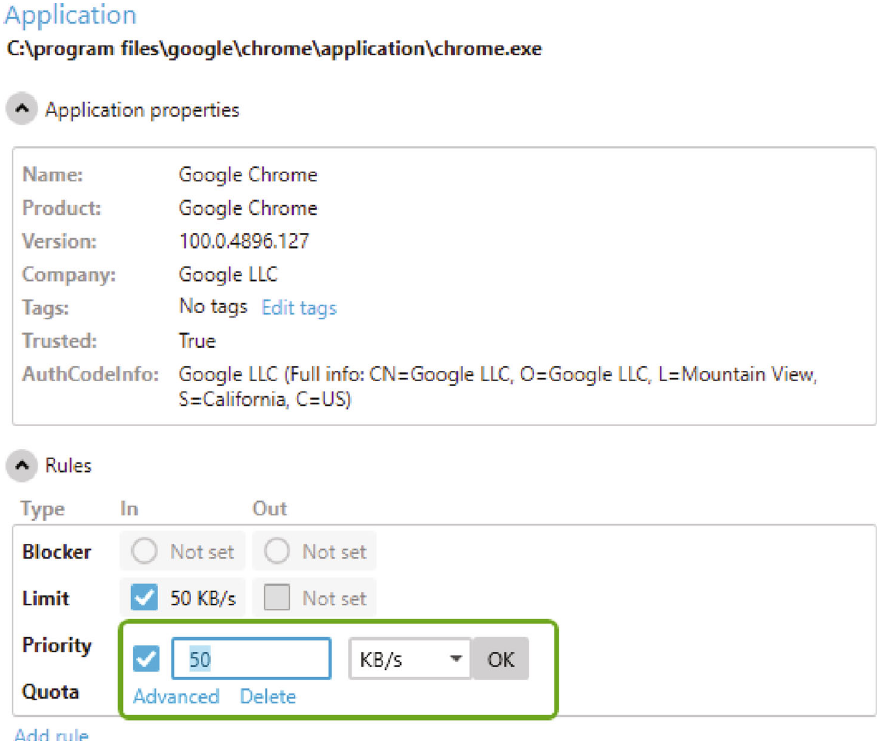
Figure 6: Net Limiter panel to control browser bandwidth.